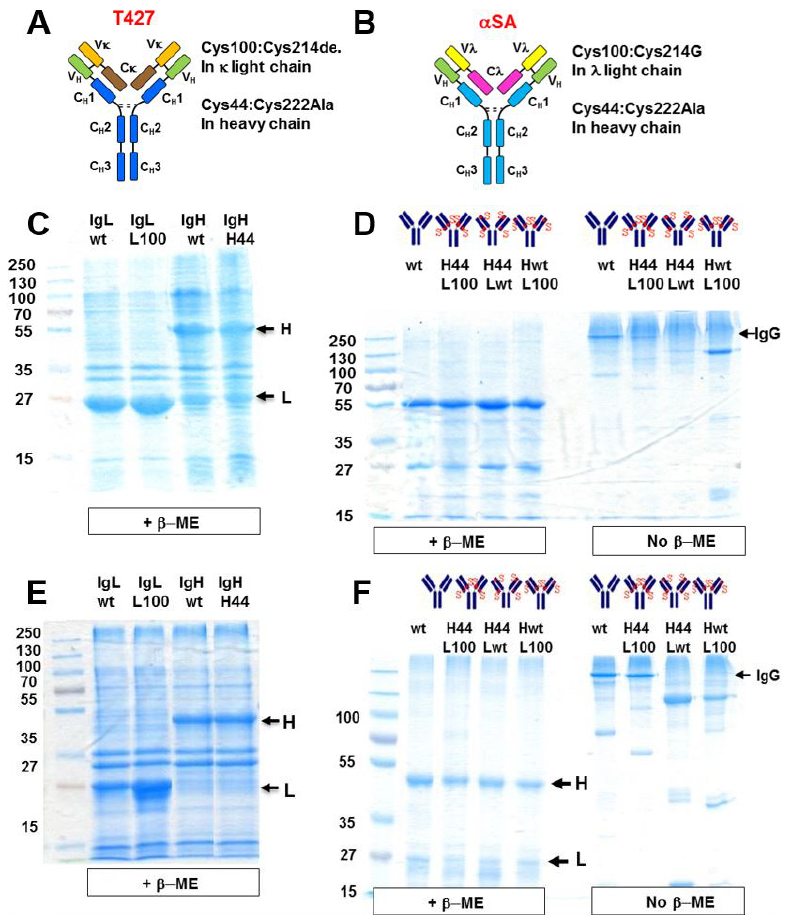
Figure 5. Analysis of heavy-light ( κ and λ ) chains pairing stabilized or not-stabilized by artificial inter-chain disulfide bonds. ( A ) Schematic structure of the “disulfide-stabilized IgGs” (T427) antibody (that has a kappa light chain); ( B ) Schematic structure of “disulfide-stabilized IgGs” anti SA ( α SA) antibody (that has a lambda light chain); ( C ) T427 heavy and light chains inclusion bodies solubilized in 6M guanidinium hydrochloride analyzed by 12% SDS/PAGE under reducing conditions; ( D ) Evaluation by SDS/PAGE (12% gel, left gel under reducing and right gel under non-reducing conditions) of heavy- κ light chains pairing. WT and H44-L100 refer to IgGs in which an inter-chain disulfide bond can be formed either by the native disulfide bond connecting C L –C H 1 domains (WT) or V H –V L domains (H44-L100)). H44-L WT and H WT-L100 represent the molecules in which an inter-chain disulfide bond cannot be formed; ( E ) Anti SA heavy and light chains inclusion bodies solubilized in 6M guanidinium hydrochloride; ( F ) Evaluation by SDS/PAGE (12% gel, left gel under reducing and right gel under non-reducing conditions) of heavy- λ light chain pairing. WT and H44-L100 refer to IgGs in which inter-chain disulfide bond can be formed (either connecting C L –C H 1 domains (WT) or V H –V L domains (H44-L100)). H44-L WT and H WT-L100 represent the molecules in which inter-chain disulfide bond cannot be